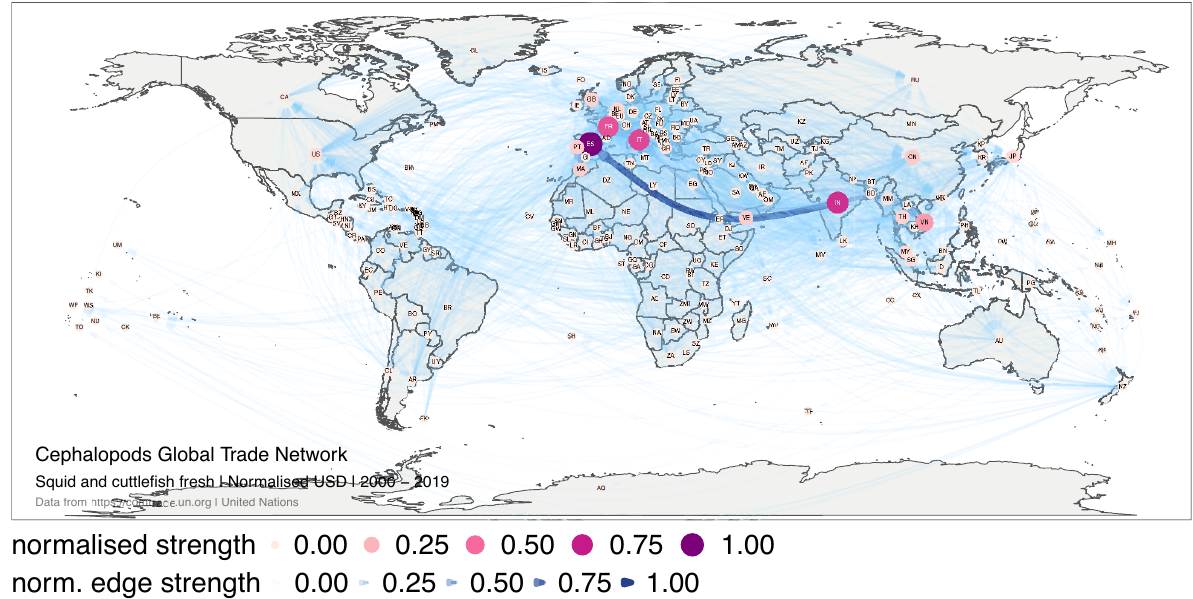
Figure 6. Global trade network for squid and cuttlefish live, fresh or chilled between 1 January 2000, and 31 December 2019 in monetary value (USD). The numbers correspond to the normalised strength for the monetary value. Each node represents a trader, and each edge represents the export–import relationship between two traders. The size and colour of the node represent the relative importance of the trader in the network in terms of its strength. The width and colour of the edge represent the relative importance of the relationship between two traders in terms of their edge strength. The figure was created with R 12 (https:// cran.r- proje ct. org) packages: “ggplot2” v.3.2.1 13 (https:// ggplo t2. tidyv erse. org), “ggmap” v.3.0.0 29 (https:// github. com/ dkahle/ ggmap) and “ggraph” v.2.0.0 30 (https:// ggraph. data- imagi nist. how the link between Netherlands and Myanmar stand out (Supplementary Fig. S7). PageRank revealed the importance of Italy, Spain, Germany and France as leading traders in the fresh squid and cuttlefish market. In the last 20 years, Europe concentrated the largest number of import relationships, which also concentrated a large monetary and volume flow. Europe leadership has been maintained over time (Fig. 7).